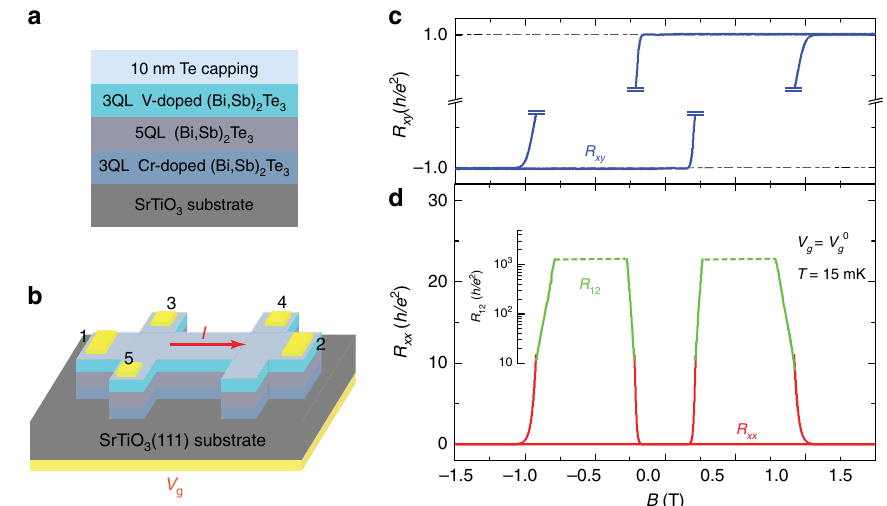
Fig. 1 QAH insulator to axion insulator transition in magnetic TI sandwich heterostructures. a Schematic of the magnetic/nonmagnetic/magnetic TI sandwich heterostructure. b Schematic of the Hall bar device used in electrical transport measurements. c Magnetic fi eld B dependence of R xy (blue) at V = V V = V 0 = + 21.5 V. d B dependence of R xx (red) and R 0 = + 21.5 V. The four-terminal longitudinal resistance R xx data are shown in red, g g 12 (green) at g g whereas the two-terminal resistance R 12 data are shown in green. When the R 12 value is comparable with or higher than the impedance of parasitic capacitance of the measurement circuit, the R 12 values measured with AC two-terminal method are not reliable and are represented by the green dashed lines. R xy values in the highly insulating regime due to the inaccuracy caused by mutual mixing from huge R xx are not shown. Measurements in c and d were taken when the environmental temperature of the dilution fridge is 15